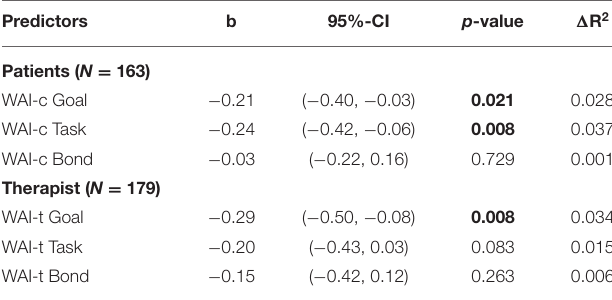
TABLE 4 | Results from six separate linear regression models predicting post-treatment OCD severity from three subscales of therapeutic alliance, i.e. Goal, Task and Bond alliance (from patient and therapeutic perspective) adjusted for baseline OCD severity and for group membership of the